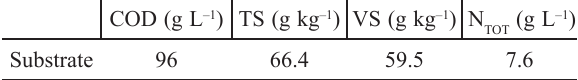
Table 1 – Basic characteristics of